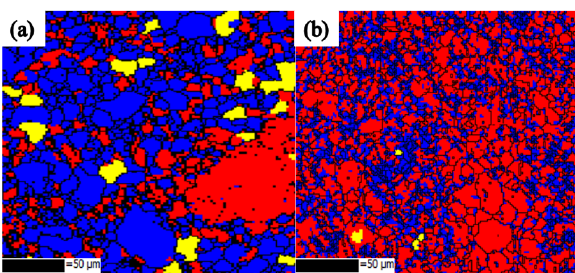
Figure 10. EBSD maps distinguishing the DRX region (blue area), sub-grains region (yellow area), and deformed region (red area) for ( a ) as-extruded and ( b ) as-rolled samples.